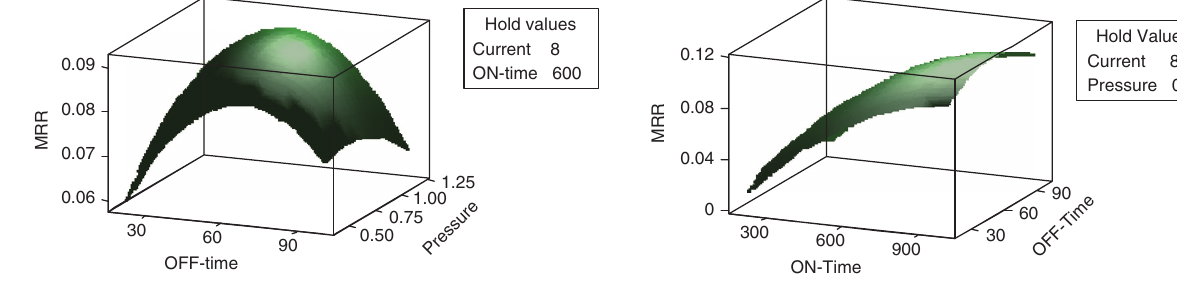
Figure 5 Surface plot of MRR vs. off time, on time.